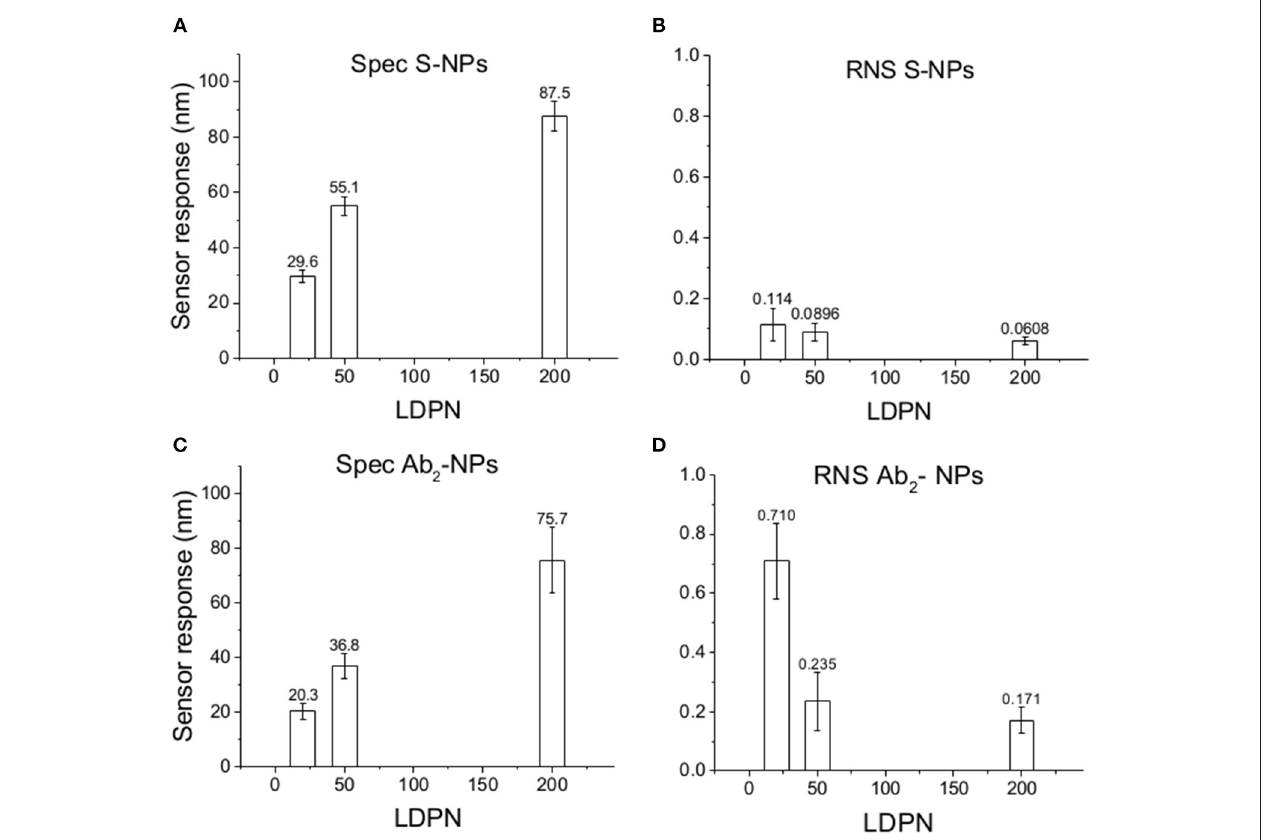
FIGURE 5 | Specific SPR sensor responses to S-NPs (A) and Ab 2 -NPs (C) and relative non-specific SPR sensor response (RNS) to S-NPs (B) and Ab 2 -NPs (D) as a function of LDPN. The data were calculated as the mean values of SPR sensor responses at the equilibrium taken from at least 3 measurements. Measurements were performed in buffer (PBS BSA